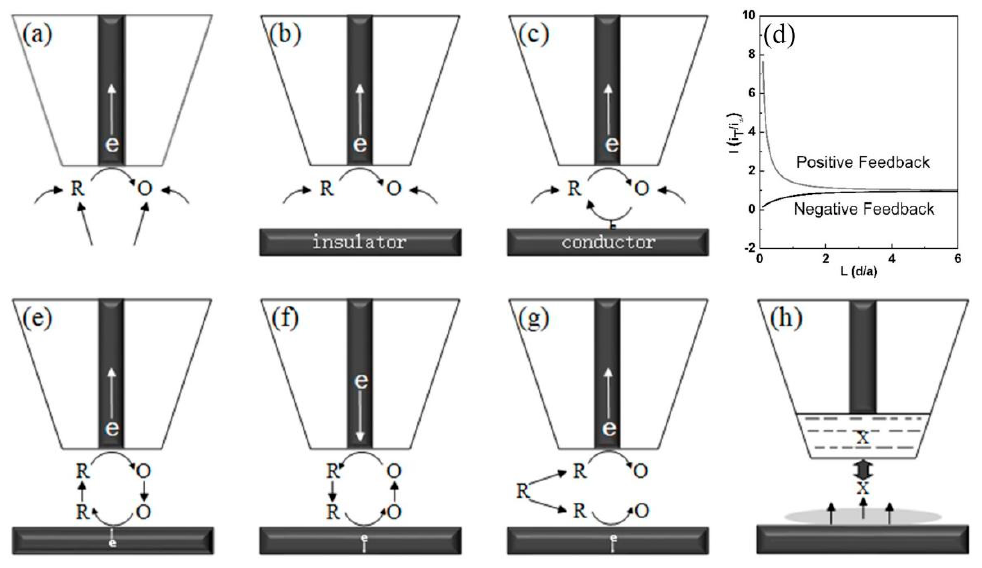
Figure 2. Different mode of the SECM operation. ( a ) Steady-state diffusion in bulk solution; ( b ) Negative feedback mode; ( c ) Positive feedback mode; ( d ) Approach curves of pure positive and negative curve; ( e ) Tip generation/substrate collection mode; ( f ) Substrate generation/tip collection mode; ( g ) Redox competition mode; ( h ) Potentiometric mode, where “X” is an ion in solution.